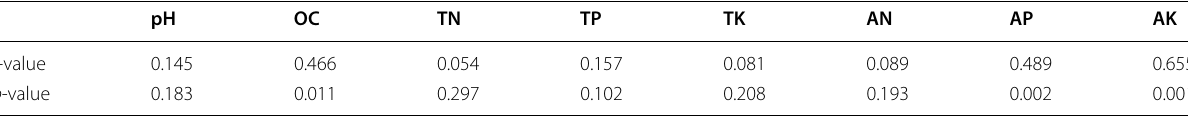
Table 3 Analysis of Mantel